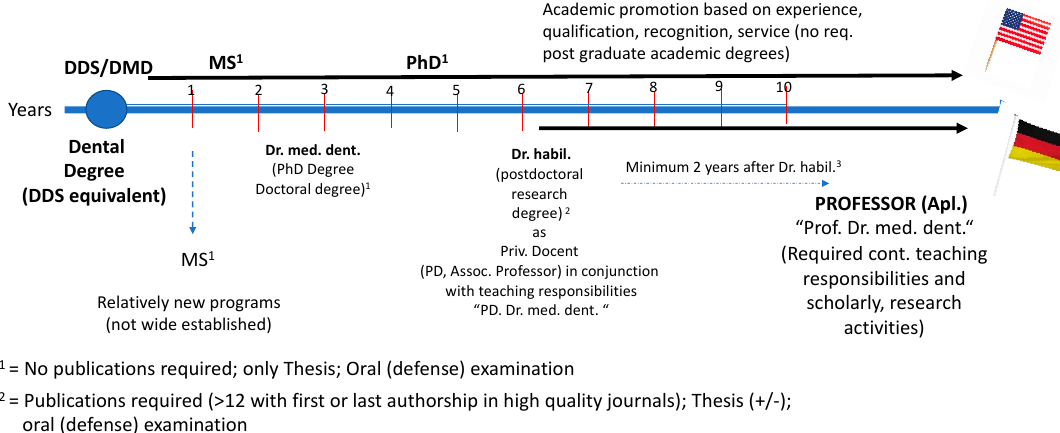
Figure 2. Academic Degrees and Postgraduate Education in Dentistry.